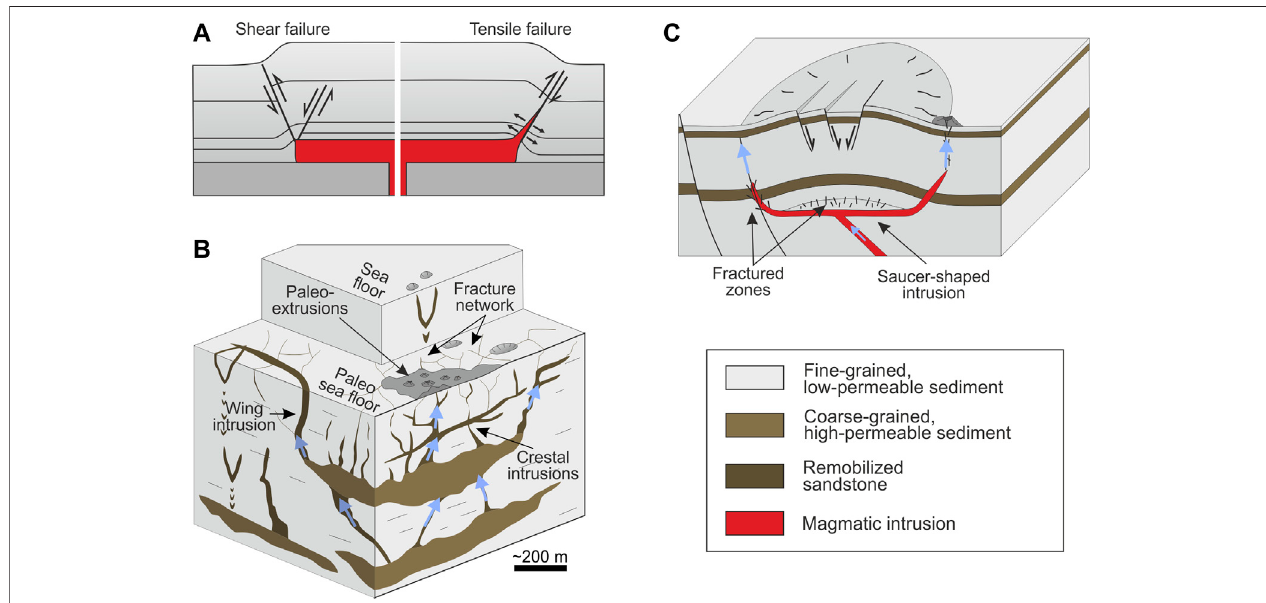
FIGURE 14 | (A) Sketch illustrating the failure modes in host rocks at the tips of propagating magmatic sills (modi fi ed from Wilson et al., 2016; Haug et al., 2018). Plastic shear failure (left) dominantly occurs in low-cohesive host rocks. Elasto-plastic tensile-shear failure (right) mainly takes place in high-cohesive host rocks. (B) Schematic block diagram of a sand injection complex, which can generally be observed in outcrop and re fl ection seismic data (modi fi ed from Hurst et al., 2003). (C) Schematic diagram showing the in fl uence of magmatic intrusion related forced folds on the fl uid system (e.g. Magee et al., 2017b).